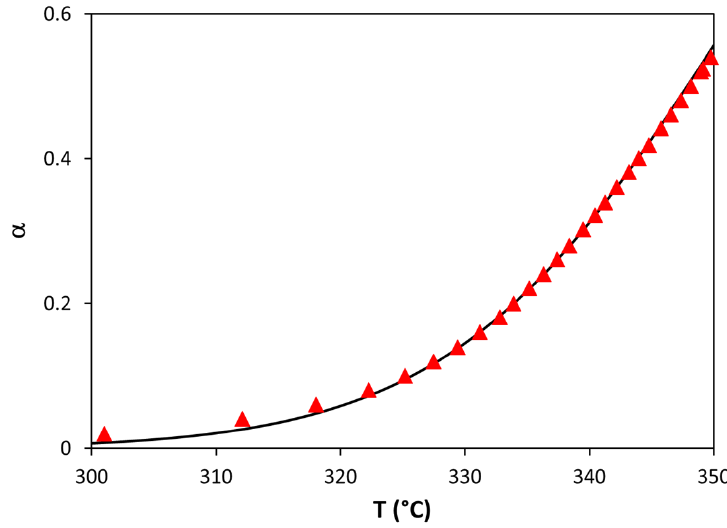
Figure 9. Comparison between experimental and random scission theoretical values of conversion